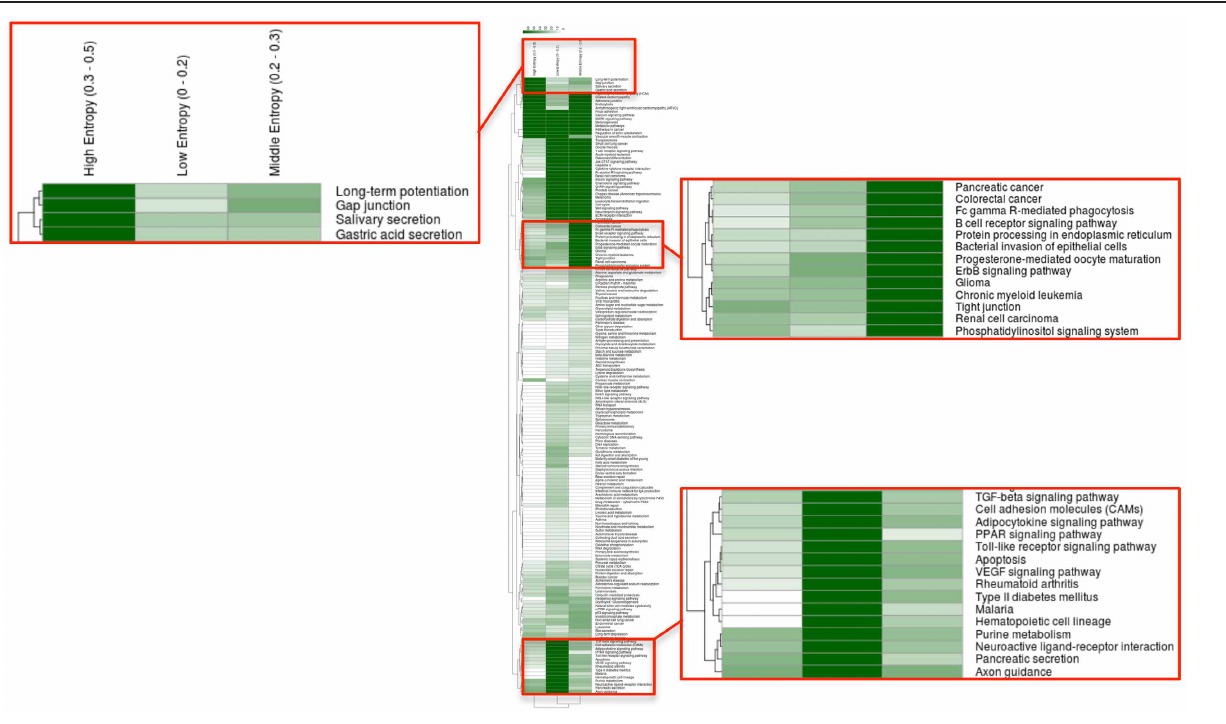
FIGURE 4 | Heat-maps illustrating the biological content of FOXO3-interaction networks as a function of gene entropy values. Biological content is inferred using enrichment in KEGG pathways ( P < 0 . 001) for three (arbitrarily selected) entropy categories